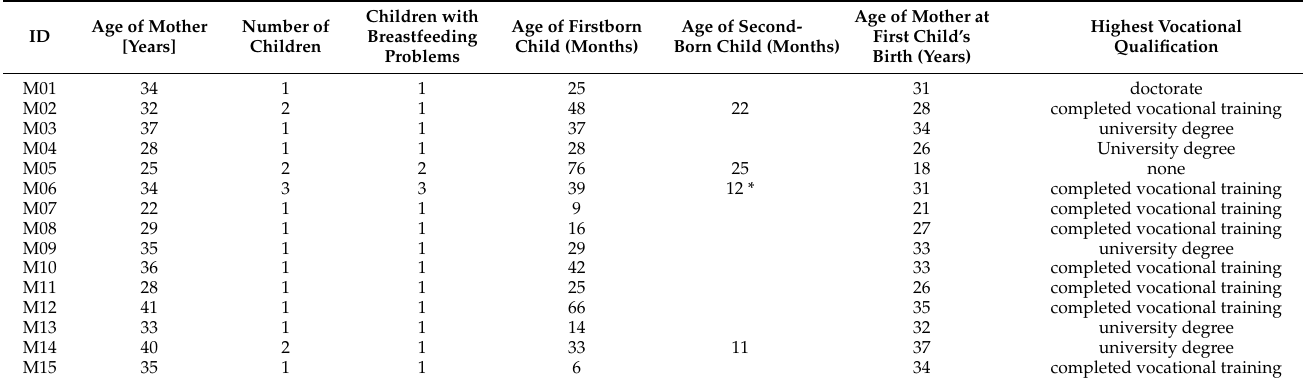
Table 1. Characteristics of the participating